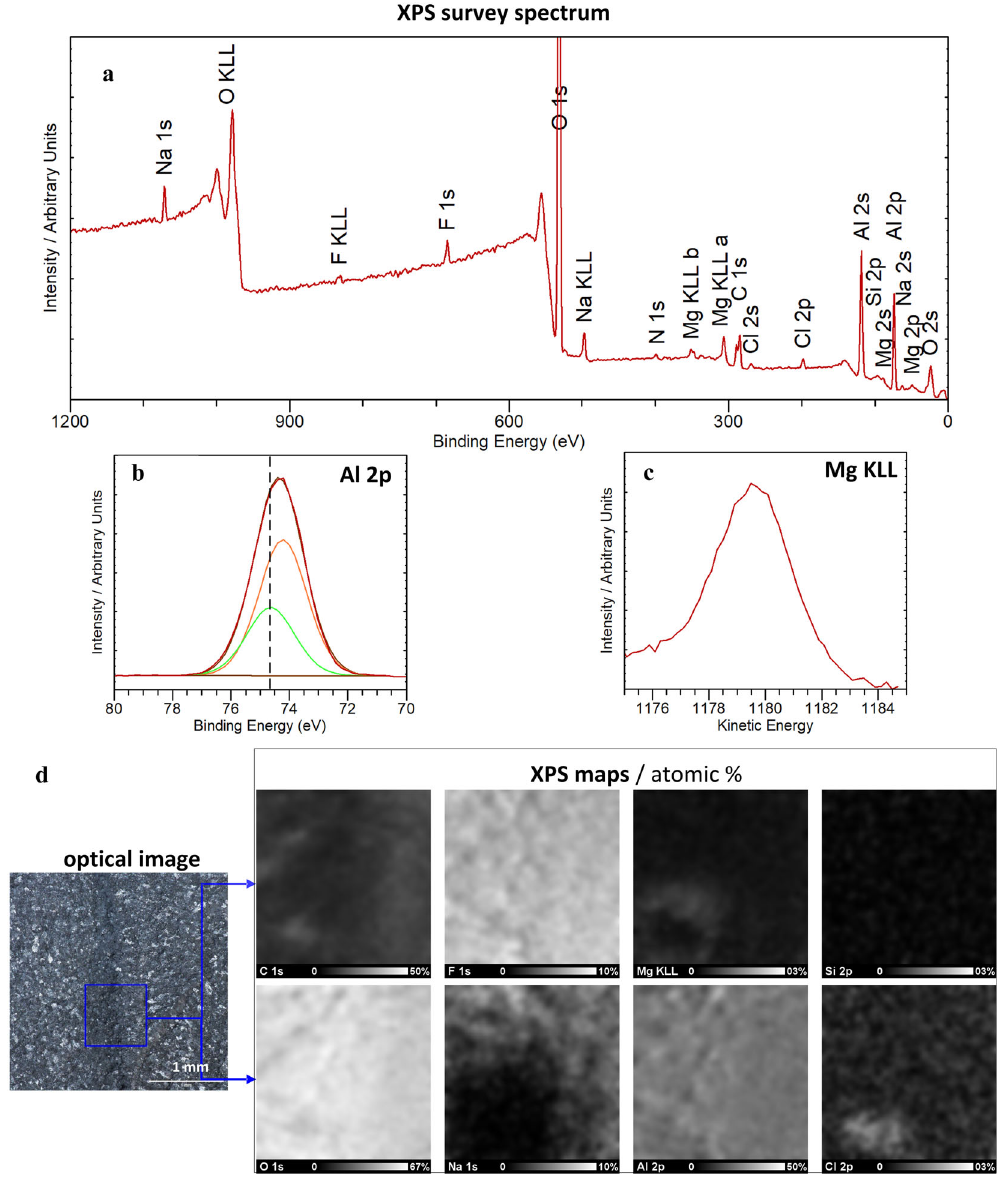
Fig. 10 XPS results from the corrode surface of the deposited layer. a XPS survey spectrum from a region covering parts of two beads; b Al 2p fi tted with a single spin-orbit pair; c Mg KLL detail spectra, and d Optical image with the XPS mapping area marked (left) and quantitative XPS maps of the detected